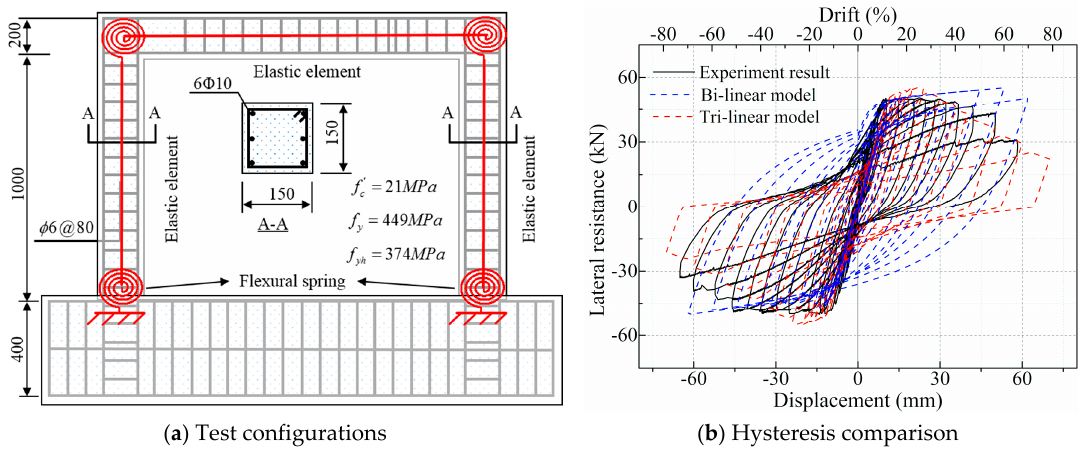
Figure 13. Comparison of the ANN-based LP model and test result [42].